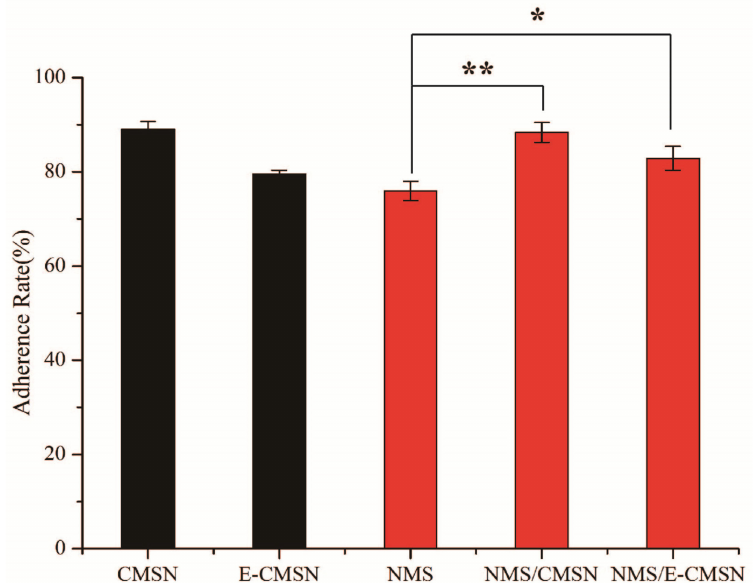
Figure 10. The mucous membrane adhesion of CMSN, E-CMSN, NMS, NMS / CMSN, NMS / E-CMSN. (n = 3, *: p < 0.05, **: p <